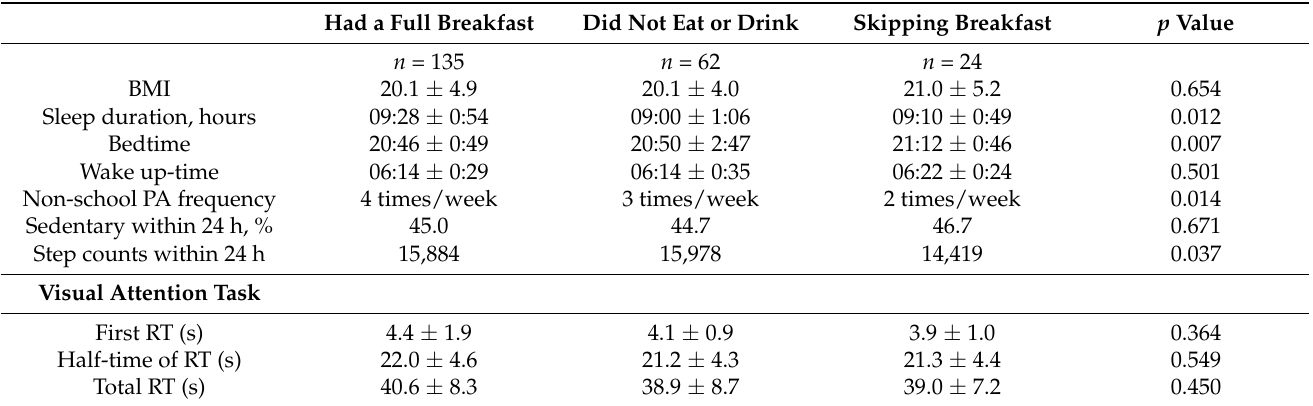
Table 2. Differences between the 3 breakfast